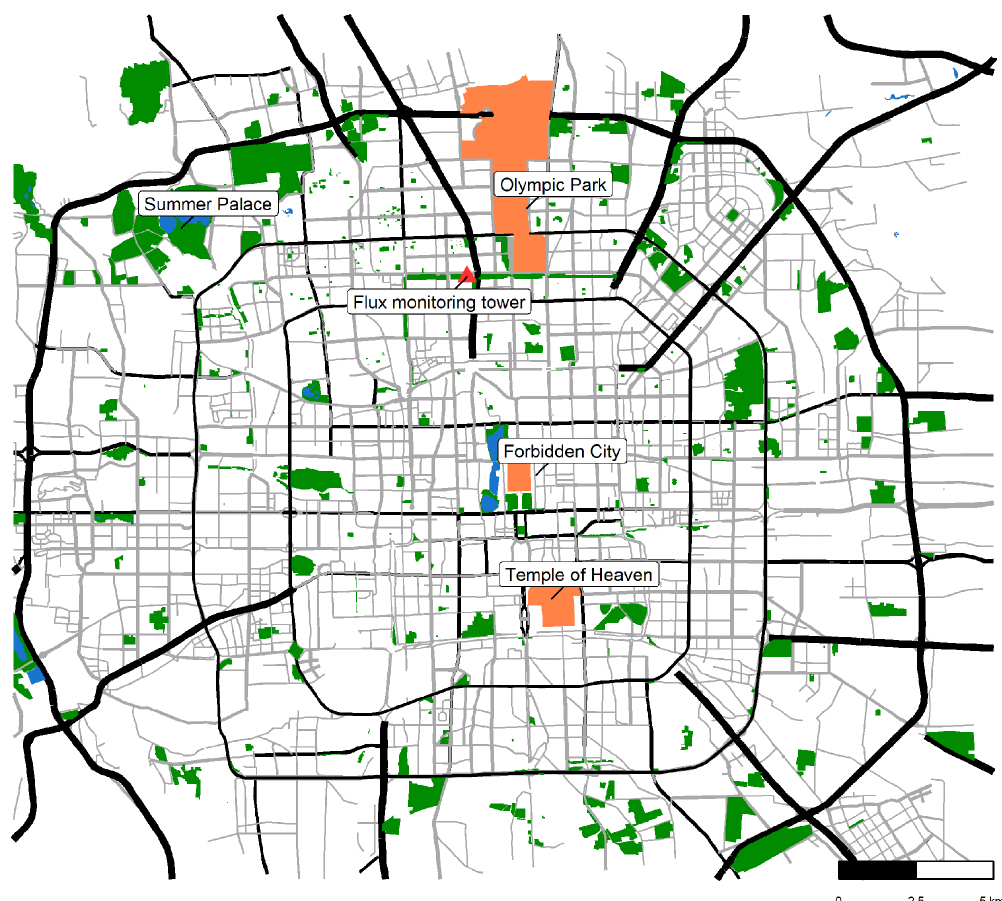
Figure 1. Measurement site position is shown by the red triangle between the third and fourth ring roads. Key landmarks of Beijing are highlighted in orange with major roads shown in black and smaller roads in grey. Parks are shown in green and water in blue. Surrounding land use is mainly residential with many restaurants within a few hundred metres of the site with the Jingzang Highway close by. Map was built using data from © OpenStreetMap contributors 2019. Distributed under a Creative Commons BY-SA